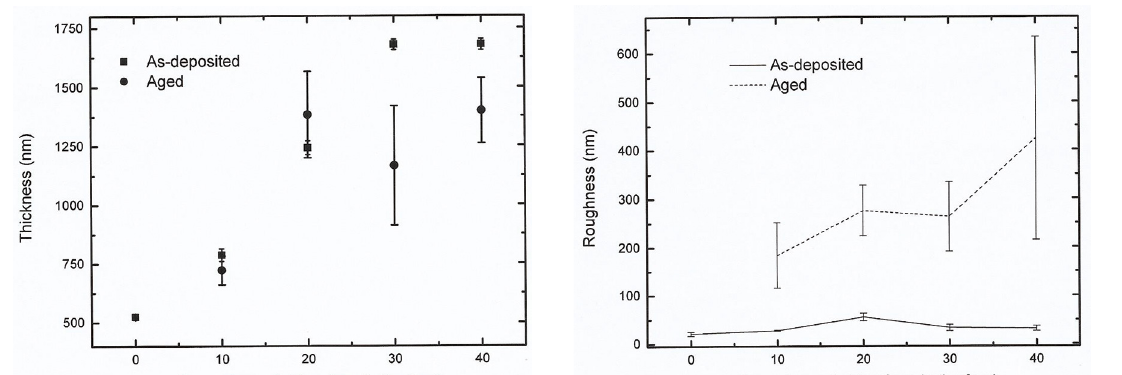
for the as-deposited Cl